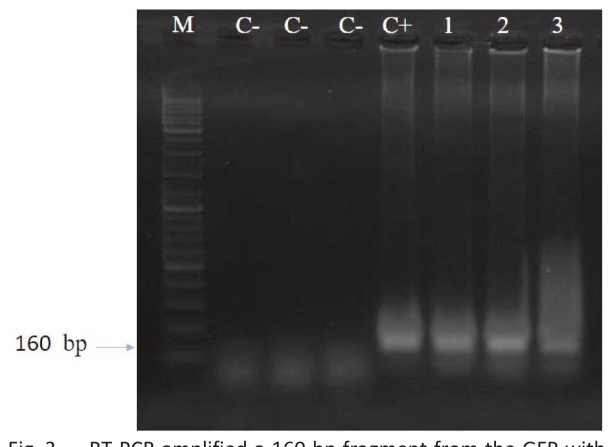
Fig. 3 - RT-PCR amplified a 160 bp fragment from the GFP with specific primers in 1% agarose gel. C- 1= negative con- trol (water template), C- 2= negative control (RNA tem- plate), C- 3= negative control (Wild type (non-inoculated plant)), C+= positive control, Lane 1= Nicotiana bentha- miana transformed plants, Lane 2= N. tabacum cv. Xanthi, Lane 3= N. tabacum cv. Samsun transformed plants, M= molecular weight marker (1 kb standard